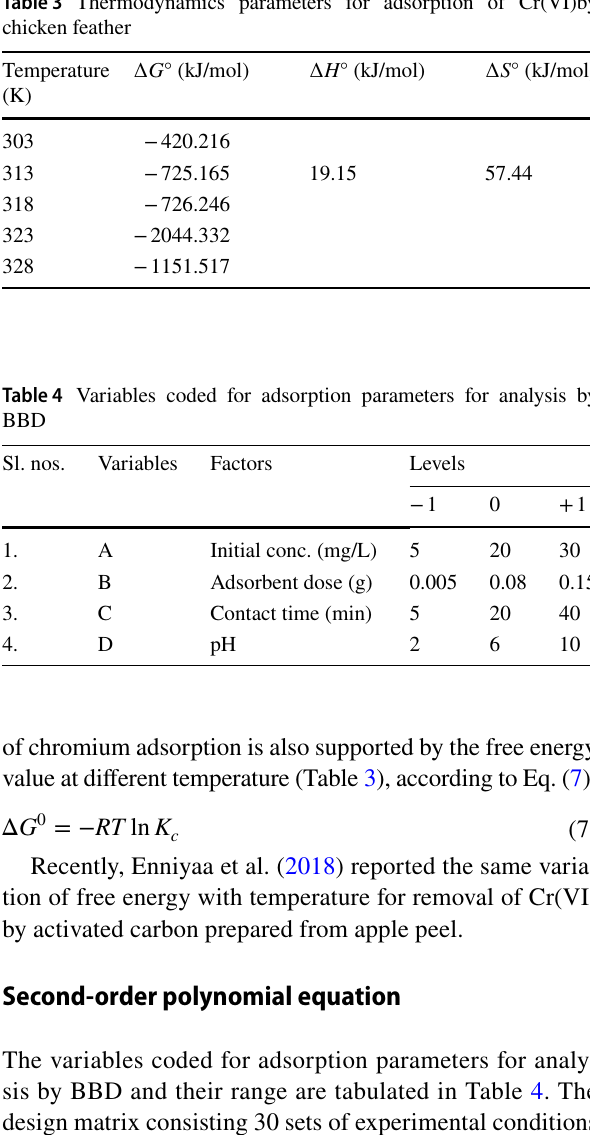
Table 3 Thermodynamics parameters for adsorption of Cr(VI)by